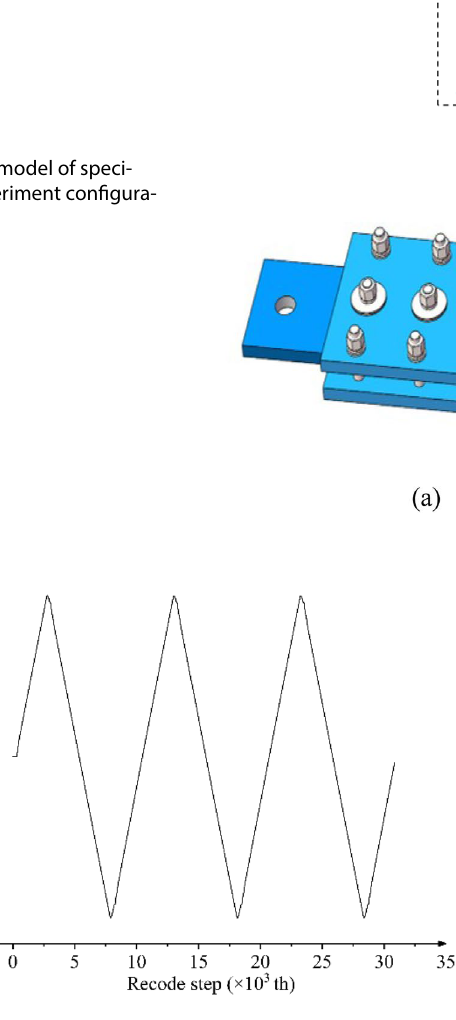
Fig. 4 Step history of displacement loading Fig. 5 Theoretically fitted hysteresis against experimental